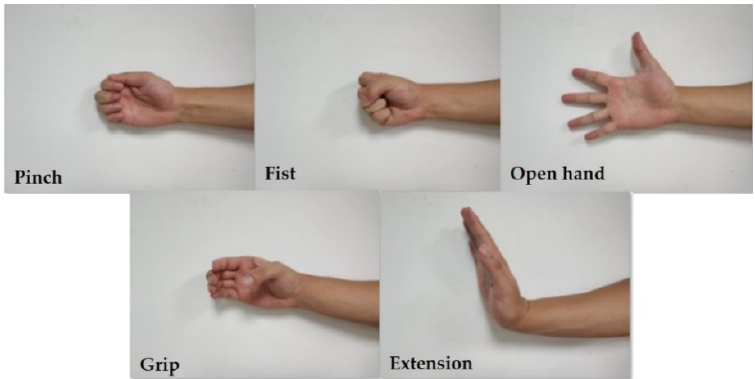
Figure 2. The hand gestures involved for the task performances: Pinch (P), Fist (F), Open hand (O), Grip (G), and Extension (E).